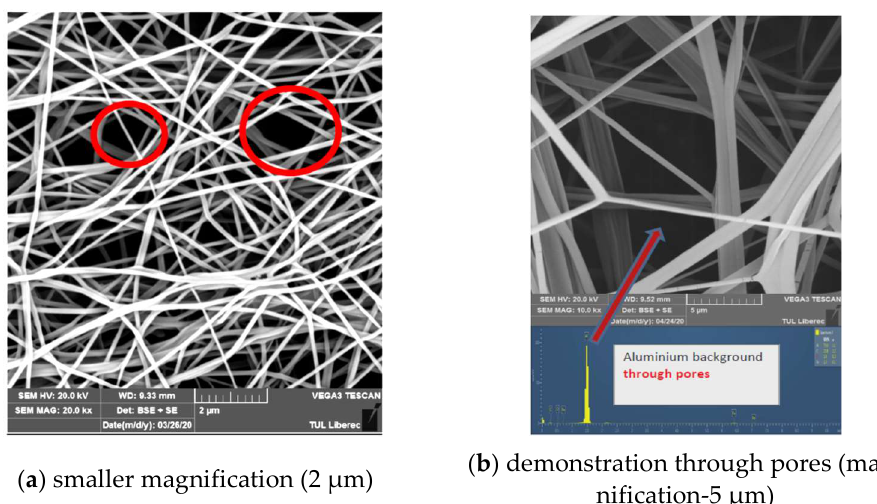
Figure 3. Pores in melt-blown PP (polypropylene) nanolayer used for face masks. A thicker barrier layer capture system is based on the increase of tortuosity and larger no throughput pores.